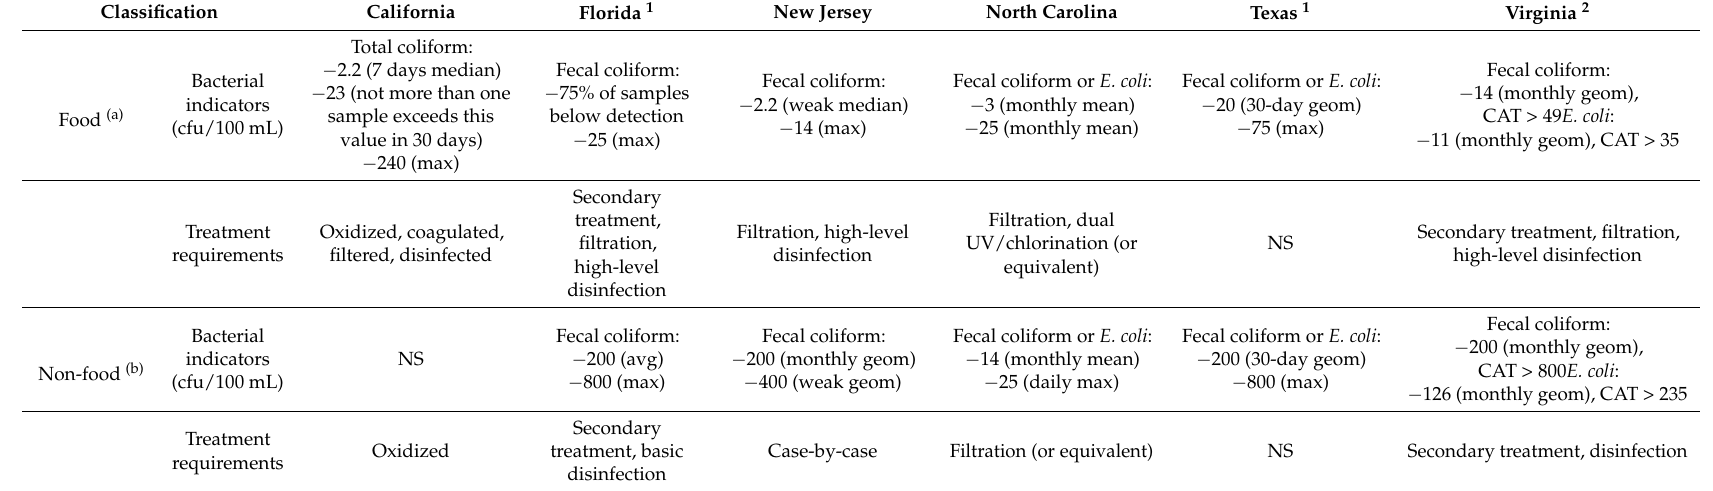
Table 1. Water quality standards of bacterial indicators for food and non-food crop irrigation in United States (modified from US EPA